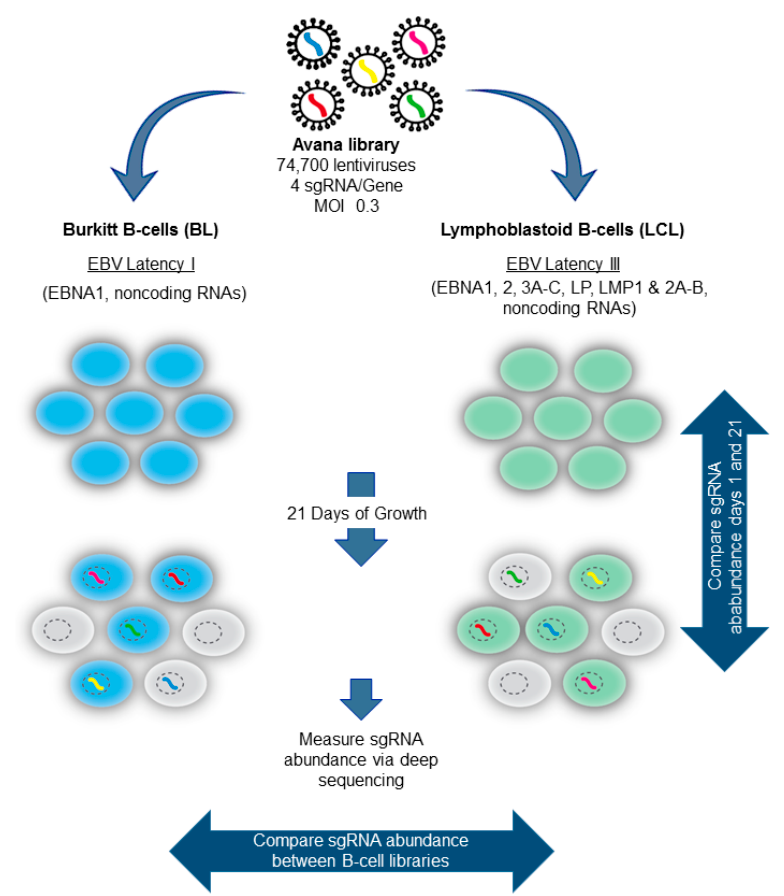
Figure 3. CRISPR-pooled screen for EBV-Transformed B cell host dependency factors. EBV+ P3HR1 Burkitt lymphoma (BL) or GM12878 lymphoblastoid cell lines (LCLs) that stably express SpCas9 were transduced with the lentivirus Avana sgRNA library at a MOI of 0.3. The transduced cells were puromycin-selected, and then passaged for 21 days. Library input and day 21 sgRNA abundances were quantitated by deep-sequencing. The STARS algorithm was used to identify sgRNAs that were significantly enriched or depleted in day 21 cell pools vs. input, or between day 21 P3HR1 and GM12878 pools.